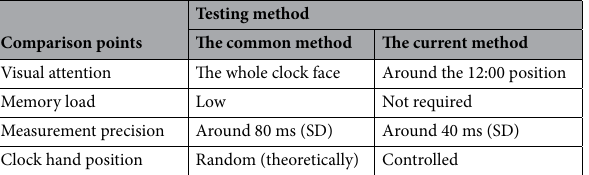
Table 1. A summary of the comparison between the common method and the current method. Please refer to the text for